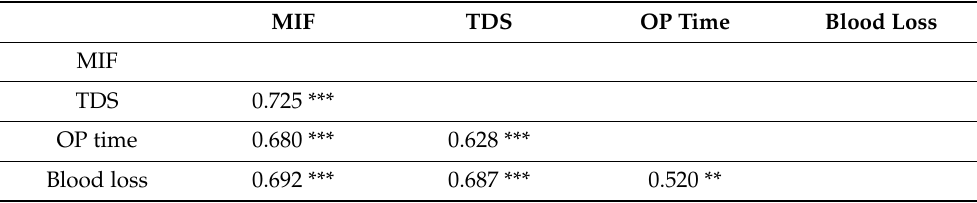
Table 5. Correlation between MIF and TDS/OP time/Blood